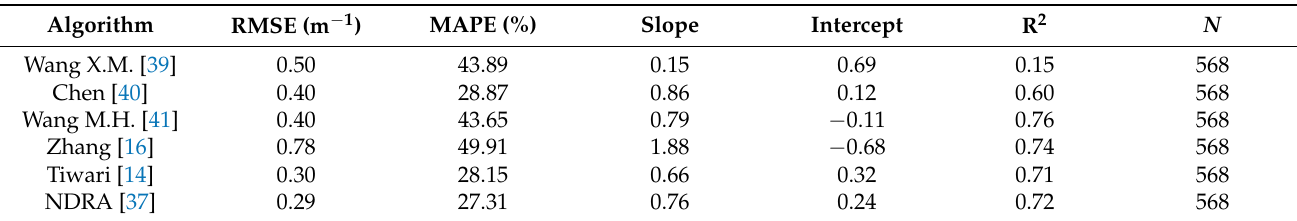
Table 2. Statistical comparison results between the estimated K d ( 490 ) from different inversion algorithms and buoy- measured K d12 ( 490 )